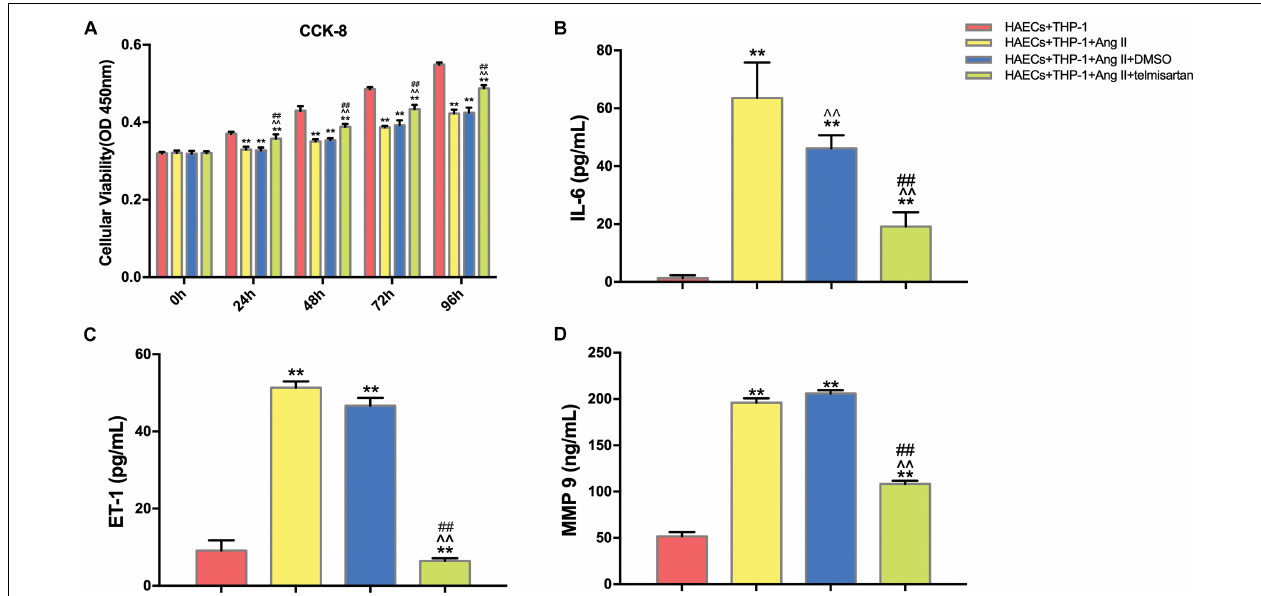
FIGURE 1 | Ang II inhibits cell proliferation and promotes ECs inflammation in co-cultured HAECs and THP-1 cells, and telmisartan counteracts this effect. (A) M0 macrophages were first co-cultured with HAECs for 24 h, and then the intervention conditions of each group were added to the lower chamber and continued to co-culture for 72 h. CCK-8 detection of cell proliferation in THP-1 cell and HAEC co-cultures at 0, 24, 48, 72, and 96 h. After 96 h of co-culture, Ang II (1 µ M, 24 h) significantly decreased the proliferation of HAECs and THP-1 cells ( P < 0.01), and this phenomenon was significantly reduced by telmisartan treatment (20 µ M, 24 h) ( P < 0.01); (B) ELISA results of IL-6 in supernatants from different samples after 96 h co-culture; (C) ELISA results of ET-1 in supernatants from different samples after 96 h co-culture; (D) ELISA results of MMP-9 in supernatants from different samples after 96 h co-culture. Ang II (1 µ M, 24 h) significantly increased the expression of IL-6, ET-1, and MMP 9 in the supernatants compared with the control group (which was not treated with Ang II). IL-6, ET-1, and MMP-9 levels were significantly lower in the telmisartan (20 µ M, 24 h) group compared with the DMSO group; ( n = 3, mean and S.D., t -test) ** P < 0.05 compared with the HAECs + THP-1 group; ∧∧ P < 0.05 compared with the HAECs + THP-1 + Ang II group; ## P < 0.05 compared with the HAECs + THP-1 + DMSO